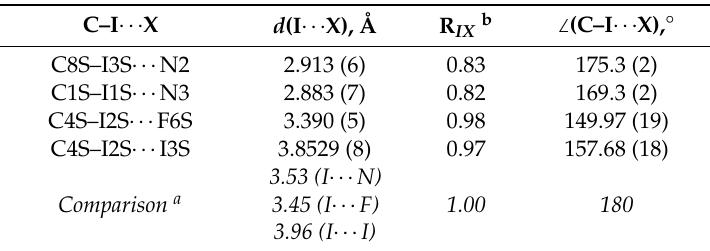
Table 1. Parameters of the C–I ··· X XBs in ASZ · 1.5( 1,4-FIB